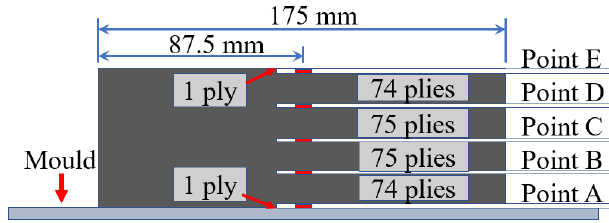
Figure 3. Location of five monitoring points.